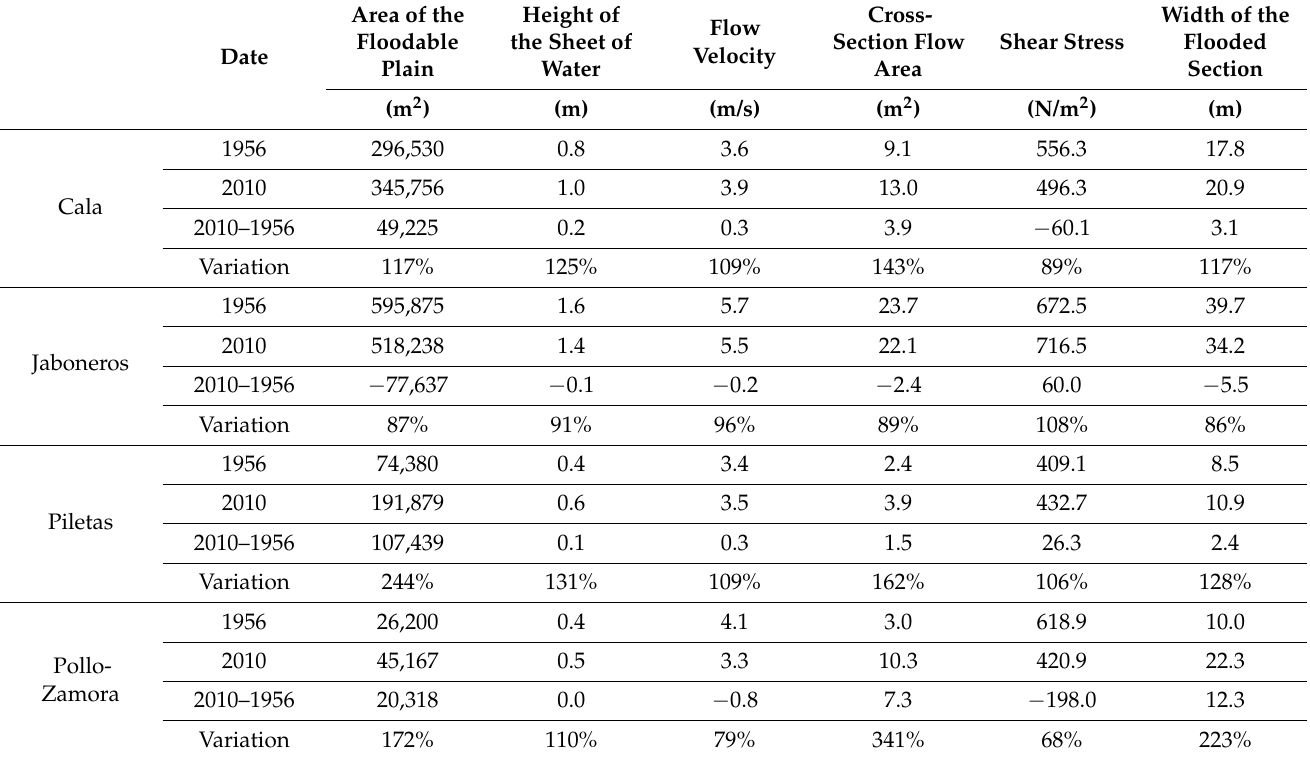
Table 7. Mean values of the hydraulic parameters in the control sections in 1956 and evolution compared to